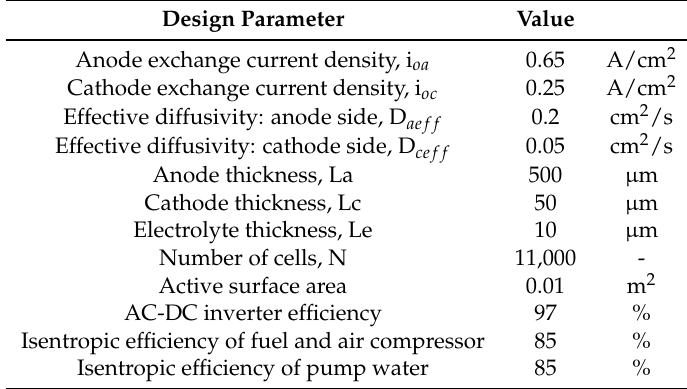
Table 2. Design parameters for the SOFC-VAR system.